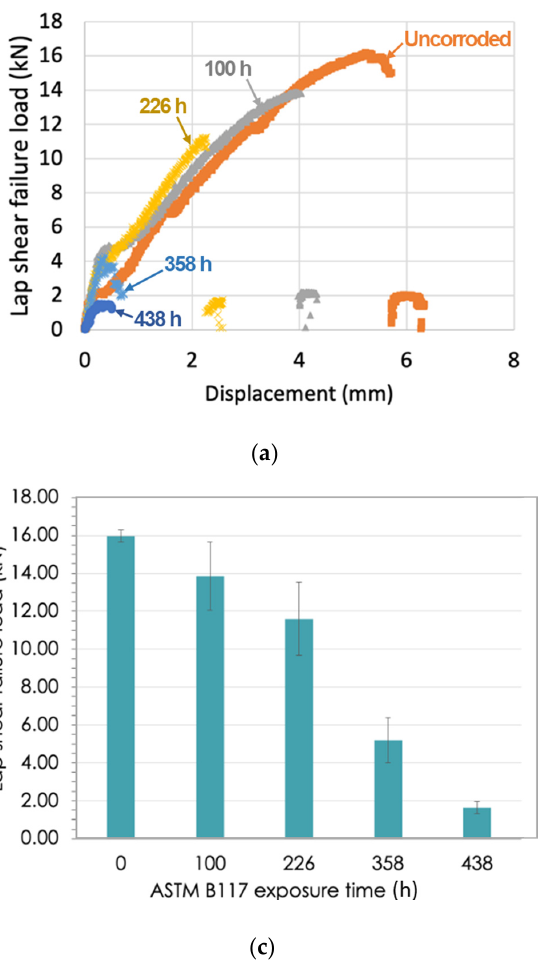
Figure 8. Corrosion volumes of lap and cross-tension joints plotted as a function of salt spray ex- mined by optical profilometry, as exemplified in Figure S3.